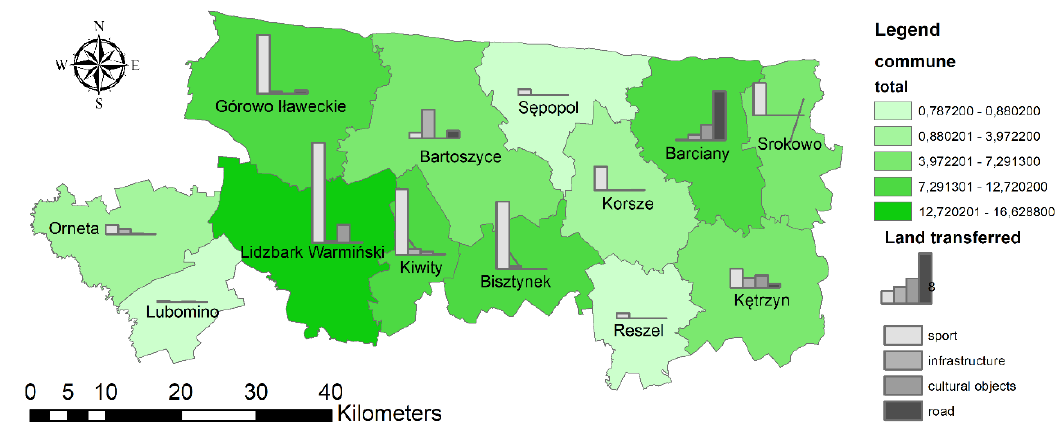
Figure 3. Area of transferred land, with the purpose of the transfer (communes) [in ha].